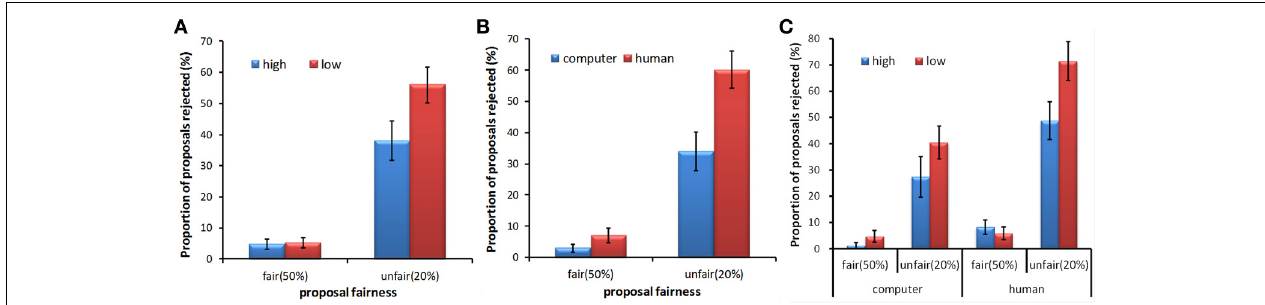
FIGURE 2 | Mean rejection rates as a function of proposal fairness for different stake sizes (A), proposer types (B), and the interaction among these three factors (C). Error bars indicate standard errors of the